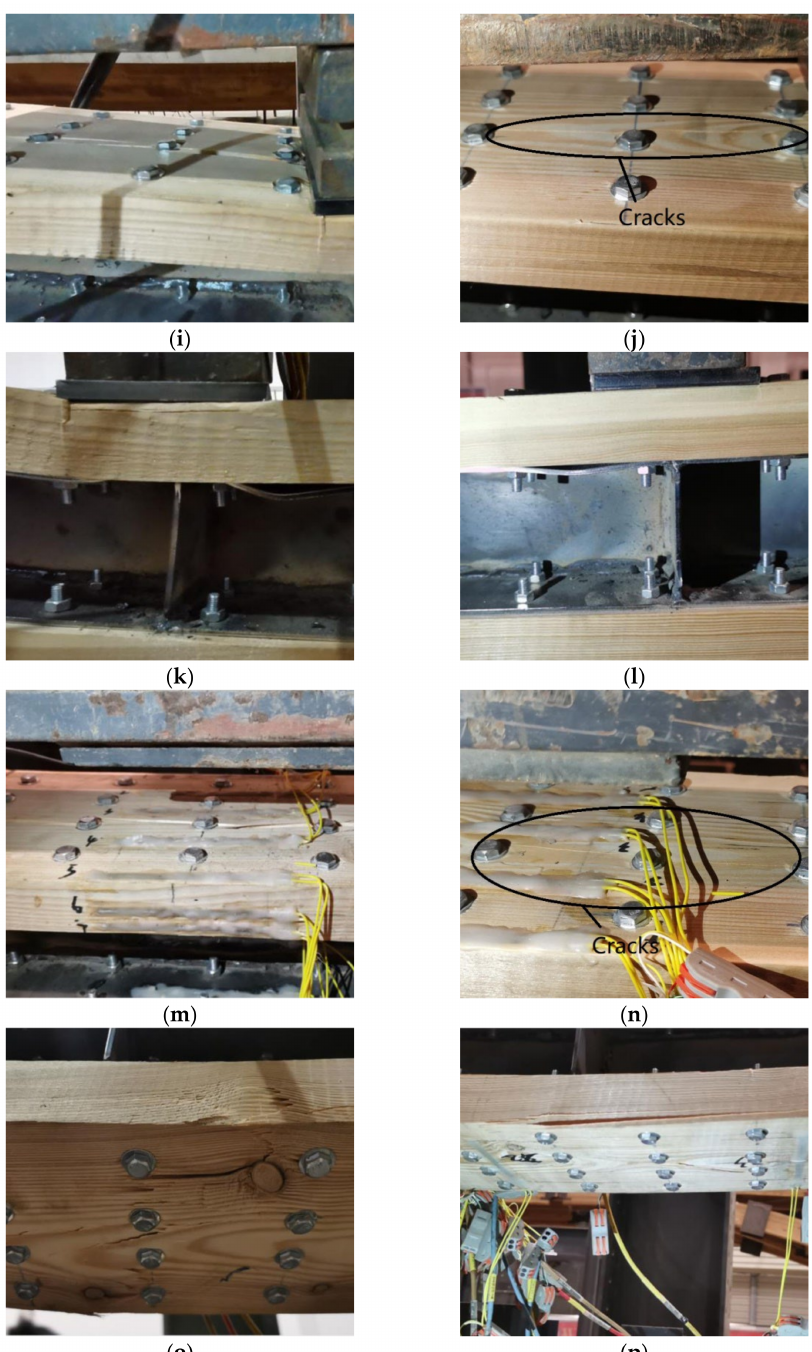
Figure 5. Failure mode of specimens in groups L1–L3: ( a ) crack in L1-1 specimen top board; ( b ) crack in L1-2 specimen top board; ( c ) L1-1 specimen base board failed in tension; ( d ) L1-2 specimen base board failed in tension; ( e ) L1-1 specimen steel flange flexure; ( f ) L2-1 specimen base board failed in tension; ( g ) L2-2 specimen base board failed in tension; ( h ) L2-1 specimen steel flange with no buckling; ( i ) L3-1 specimen cracking in the bending and shearing section of the top board; ( j ) L3-2 specimen cracking in the bending and shearing section of the top board; ( k ) L3-1 specimen top board partial crush and steel flange buckling; ( l ) L3-2 specimen top board partial crush and steel flange buckling; ( m ) L3-1 specimen top board cracked exclusively in the curved section; ( n ) L3-2 specimen top board cracked exclusively in the curved section; ( o ) L3-1 specimen base board failed in tension; ( p ) L3-2 specimen base board failed in